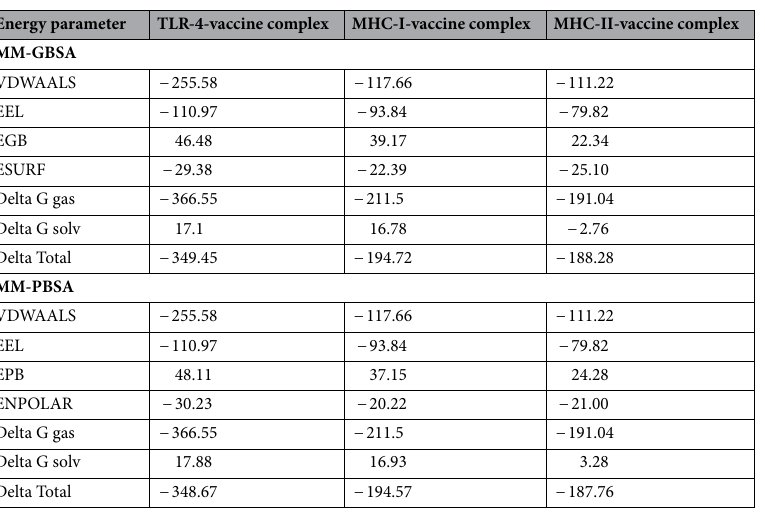
Table 7. Overview of the differences in binding free energies between vaccines and their receptors and are given in